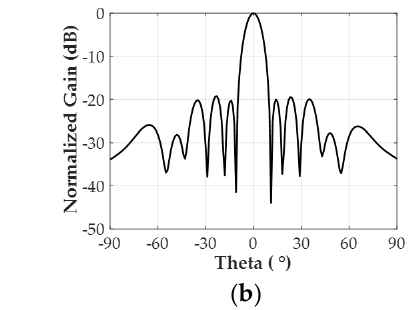
Figure 7. ( a ) Non-uniformly spaced 12-element patch array without a power divider. ( b ) Normalized gain of the non-uniformly powered and non-uniformly spaced patch array without a power divider in the simulation.